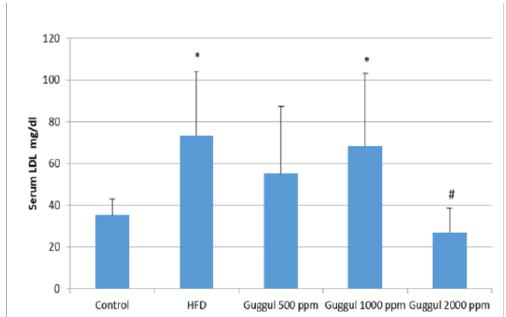
Figure 4. Effects of guggulsterone on the LDL level of mice models with high-fat diet induced NAFLD. * is a significantly different compared to the control group (P<0.05). # is significantly different compared with the HFD group (P<0.05).